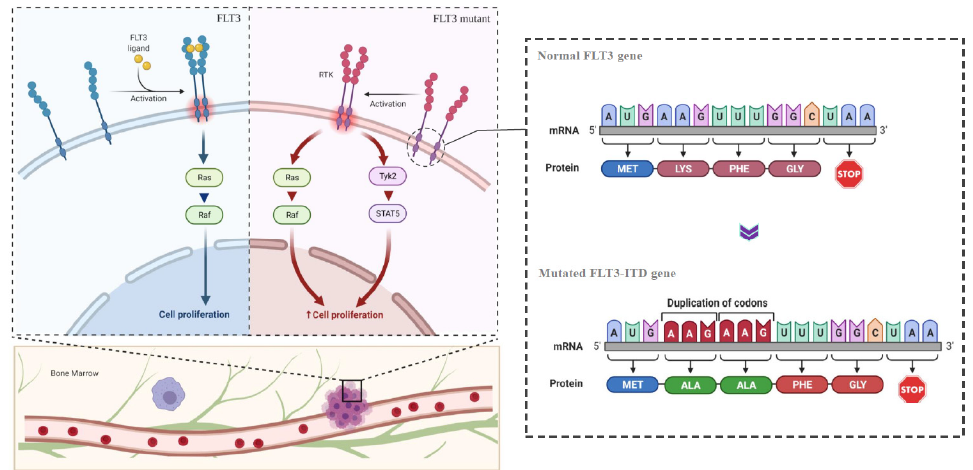
Figure 1. Diagram showing the difference between normal and mutated FLT3 genes with internal tandem duplications leading to ligand-independent activation and dimerization of receptor tyrosine kinase which causes uncontrolled cell proliferation and myeloid carcinoma.